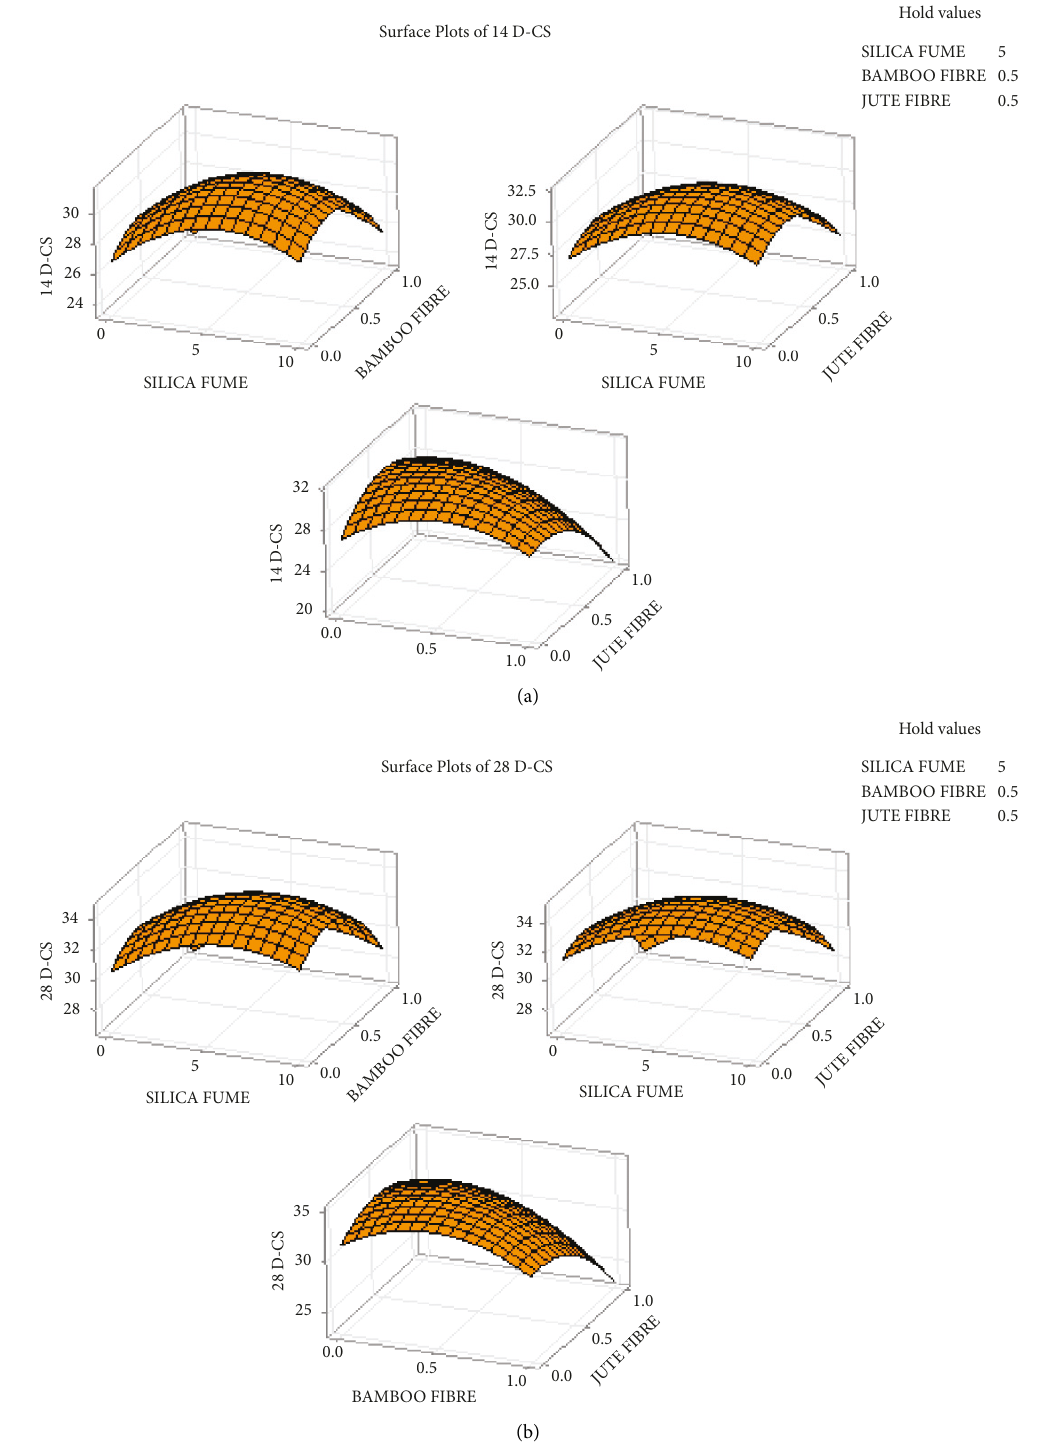
Figure 8: Surface plot for (a) fcs